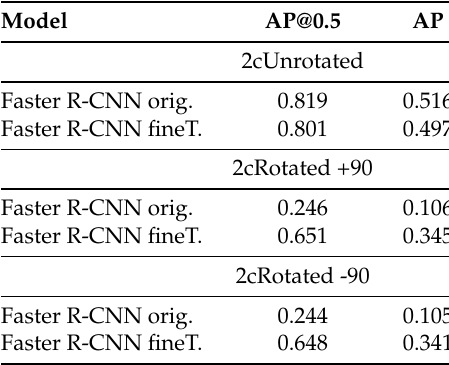
Table 6. People detectors performance, comparison between pre-trained detector and fine-tuned.